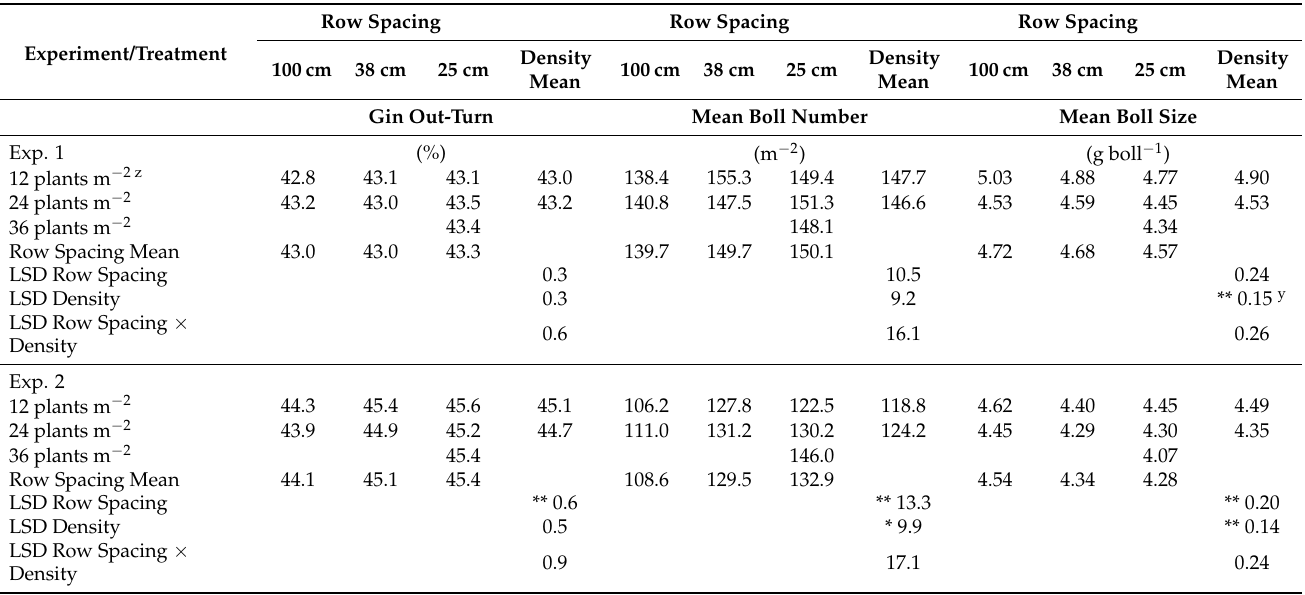
Table 5. Gin out-turn, boll number and boll size for Exps. 1 and 2 comparing inter and intra row plant density. LSDs are presented for comparison between plant densities, row spacing and the interaction between row spacing and plant density.